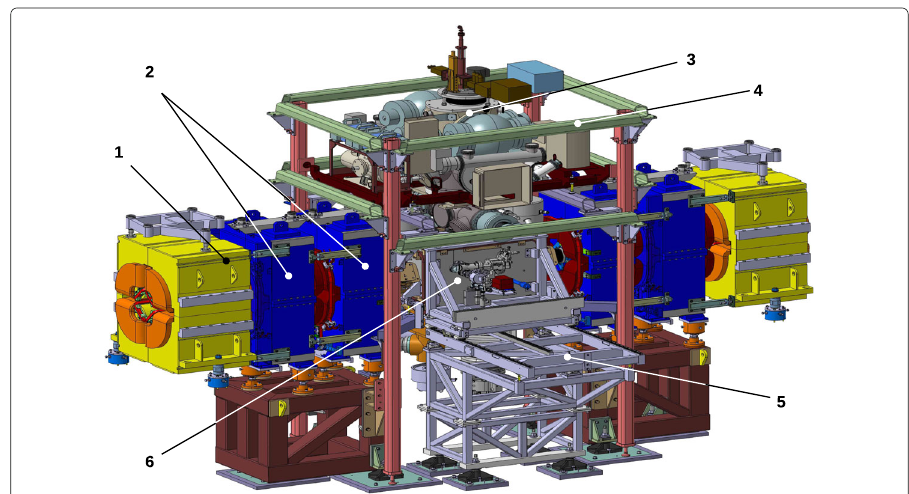
Fig. 6 View of the PAX installation at COSY from the interior of the ring (the beam comes from the left). 1: COSY quadrupole magnet; 2: two of the four PAX quadrupoles forming the low- β insertion by doublet focusing (DF-FD); 3: atomic beam source (ABS); 4: support system; 5: flange supporting rail system; 6: PAX target chamber housing the detector and the storage cell. The Breit-Rabi polarimeter (BRP) and the target-gas analyzer (TGA) are mounted towards the outside of the ring. (Figure taken from Ref.